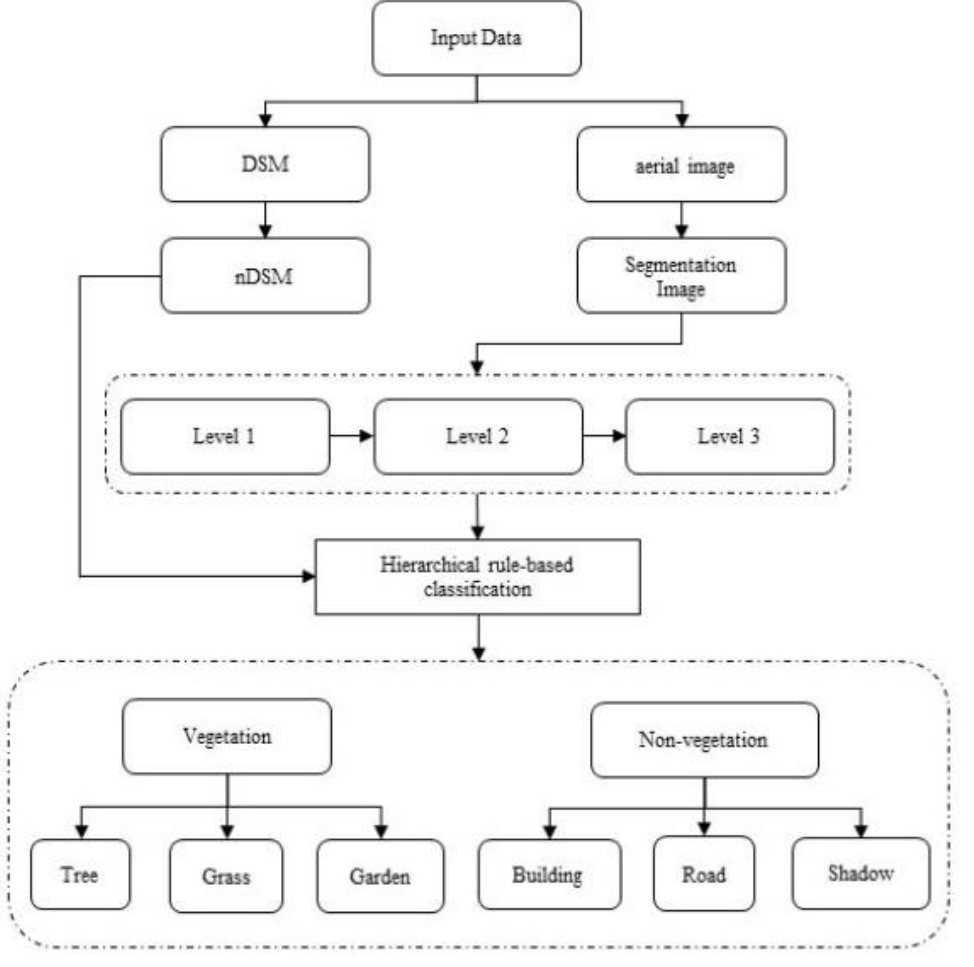
Figure 2. Flowchart of the object-based classification